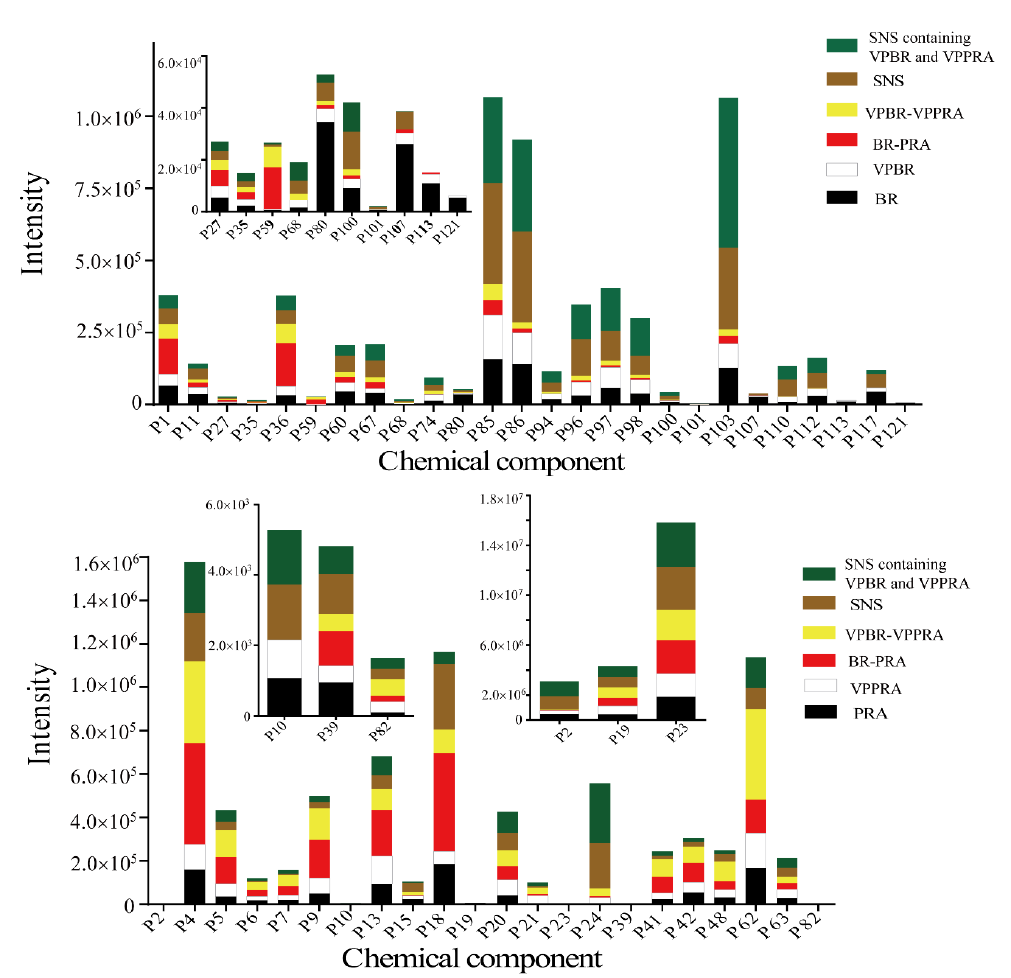
Figure 3. Contents of components identified with significant differences in individual herb, herb-pair, and complicated Chinese herbal formula of SNS. Table 4. Results of t -test of 12 peaks from AFI and GRM showing significant difference ( n = 6).